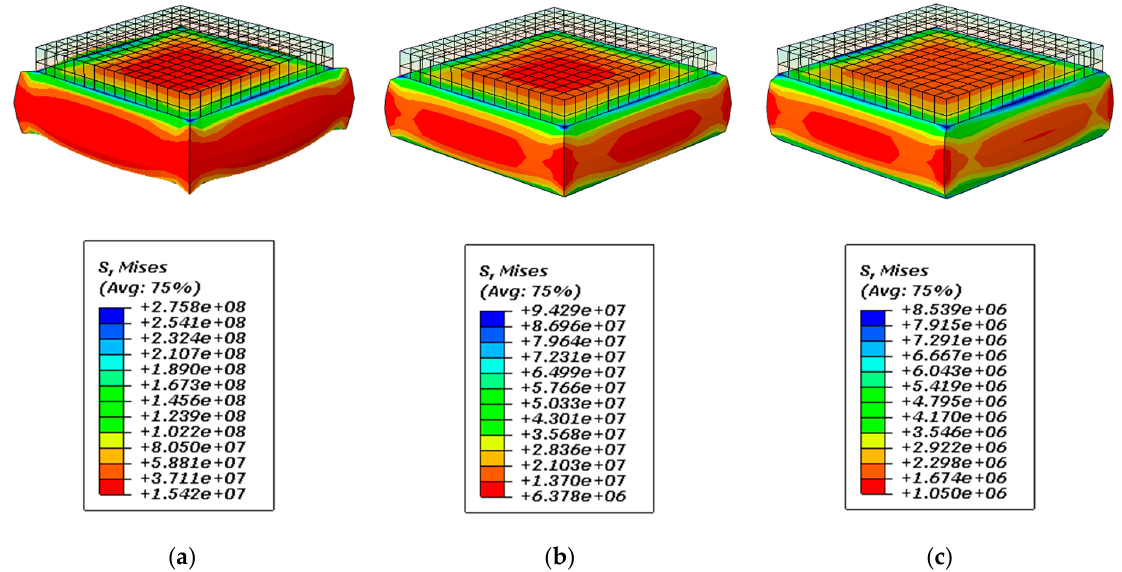
Figure 7. Stress distribution in Styrene SMP foam at different temperatures at the end of loading. The stress contours relate to results presented in Figure 6 for ( a ) T = 20 ◦ C, ( b ) T = 60 ◦ C, and ( c ) T = 100 ◦ C.